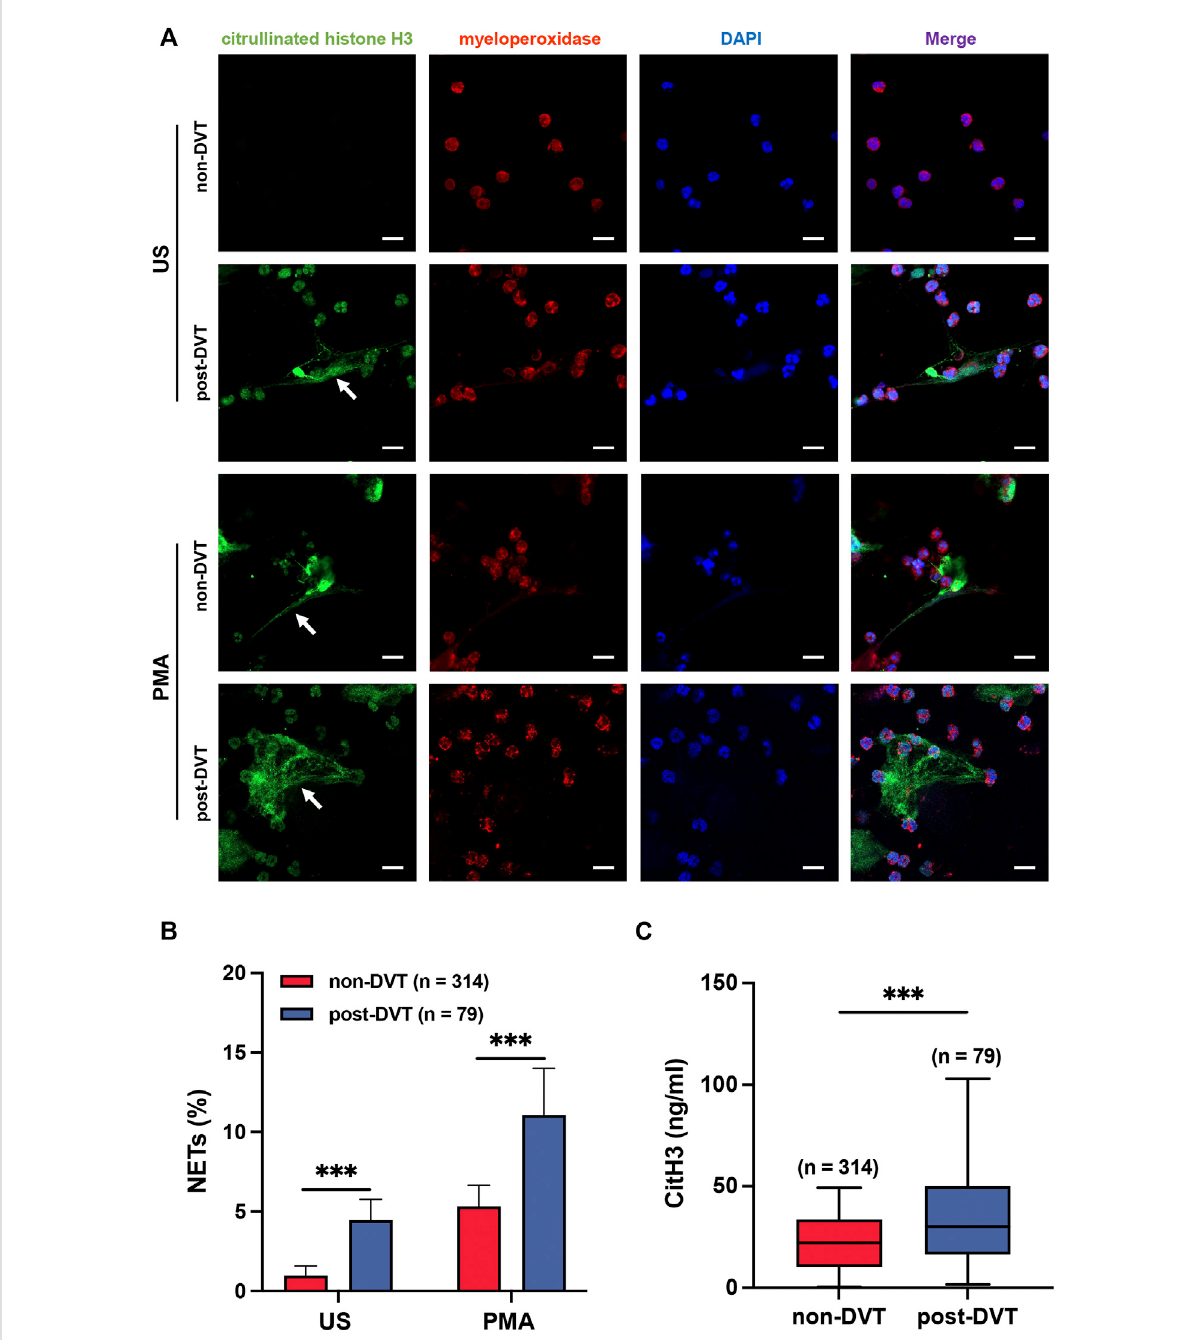
FIGURE 2 Neutrophils from the blood of patients in the post-DVT group form more NETs compared to the non-DVT group. (A) Representative images of Immuno fl uorescence staining of peripheral blood neutrophils from patients in non-DVT and post-DVT groups for MPO (red) and CitH3 (green) are shown, and the cell nuclei were stained with DAPI (blue). The white arrows indicate the typical NETs structure. Scale bars, 30 μ m. US, unstimulated. (B) Results of the statistical analysis show the percentage of NETs in each group ( n = 314 in the non-DVT group and n = 79 in the post-DVT group). *** p < 0.001. (C) Plasma samples were analyzed for CitH3 ( n = 314 in the non-DVT group and n = 79 in the post-DVT group). *** p <